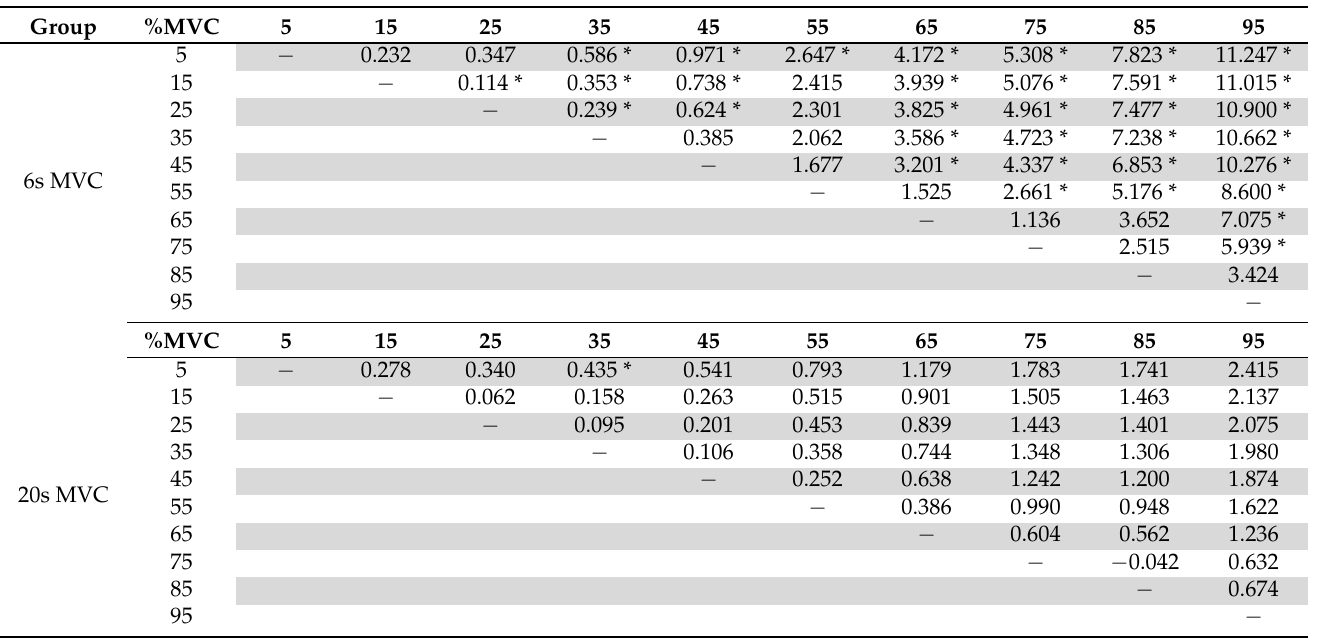
Table 4. Mean Differences in CE